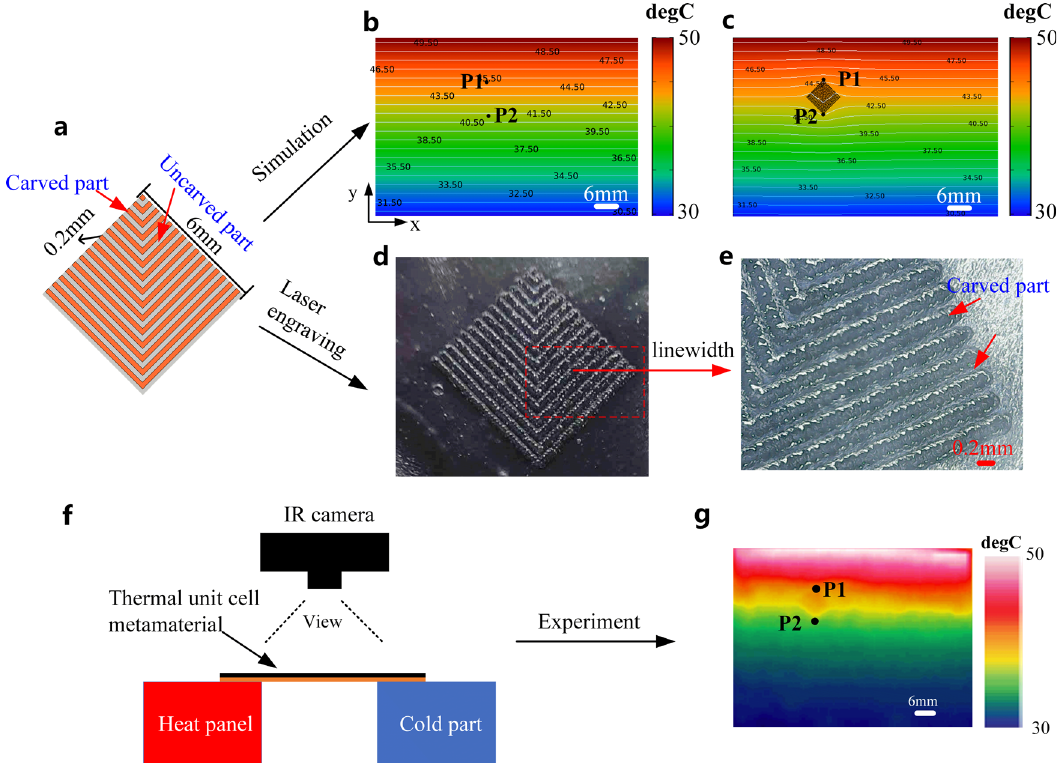
Fig. 2 Simulative and experimental performance evaluation of temperature map with thermal unit block (TUB) metasurface in contact with same temperature sources at both up and downsides. a Structure of the TUB metasurface. The side length of the model is 6 mm; the average linewidth of the carved area is 210 μ m and that of the uncarved area is 190 μ m. b Temperature map without TUB metasurface obtained from numerical simulation (as the thermal reference). c Temperature pro fi les of TUB metasurface obtained from numerical simulation. d The TUB metasurface carved by CO 2 laser engraving processing. e Zooming in the red dashed box of Fig. 2d to observe the detail of the processing and measure the linewidth of the unit block through the electronic magnifying glass. f Scheme of the experimental apparatus illustrating the method for temperature measurement via IR camera. g Temperature pro fi les of temperature-responsive TUB metasurface obtained from experimental